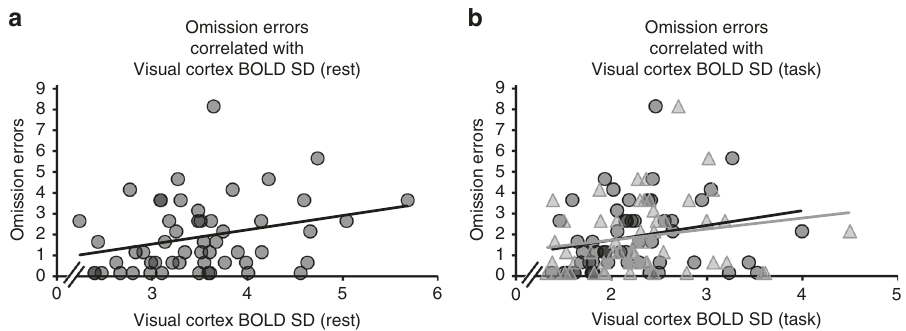
Fig. 2 BOLD variance is positively associated with omission errors during visual detection. Pearson correlations that accounted for the dependence among the repeated measures, were calculated to study the relationship between behavior and BOLD SD in visual cortex during rest ( a ) and task ( b ). a Individual resting-state BOLD SD values in visual cortex (extracted from cluster 1, x -axis) correlated positively with individual omission errors during visual detection ( y -axis) at the same times of day ( r = 0.54, n = 54, P < 0.001). The scatter plot shows individual resting-state BOLD SD values and corresponding omission errors for all ToD (linear regression line of best fi t included in the graph). b Correlation between omission errors and BOLD SD persisted during visual detection, linking BOLD SD reductions to performance ( y -axis: omission errors; x -axis: BOLD SD during visual detection task). BOLD SD values were extracted from the cluster in the primary and secondary visual cortex (circles: r = 0.43, P = 0.003, n = 54. Local maxima in the left calcarine sulcus (MNI − 10 − 68 12) and left lingual gyrus (MNI − 8 − 66 2), see Fig. 3) and from the cluster in the secondary visual cortex (triangles: r = 0.42, P = 0.004, n = 54. Local maxima in the left (MNI − 2 − 82 24) and right cuneus (MNI 4 – 82 20), see Fig. 3). The scatter plot shows individual BOLD SD values during visual detection and corresponding omission errors for all ToD (linear regression line of best fi t included in the graph)